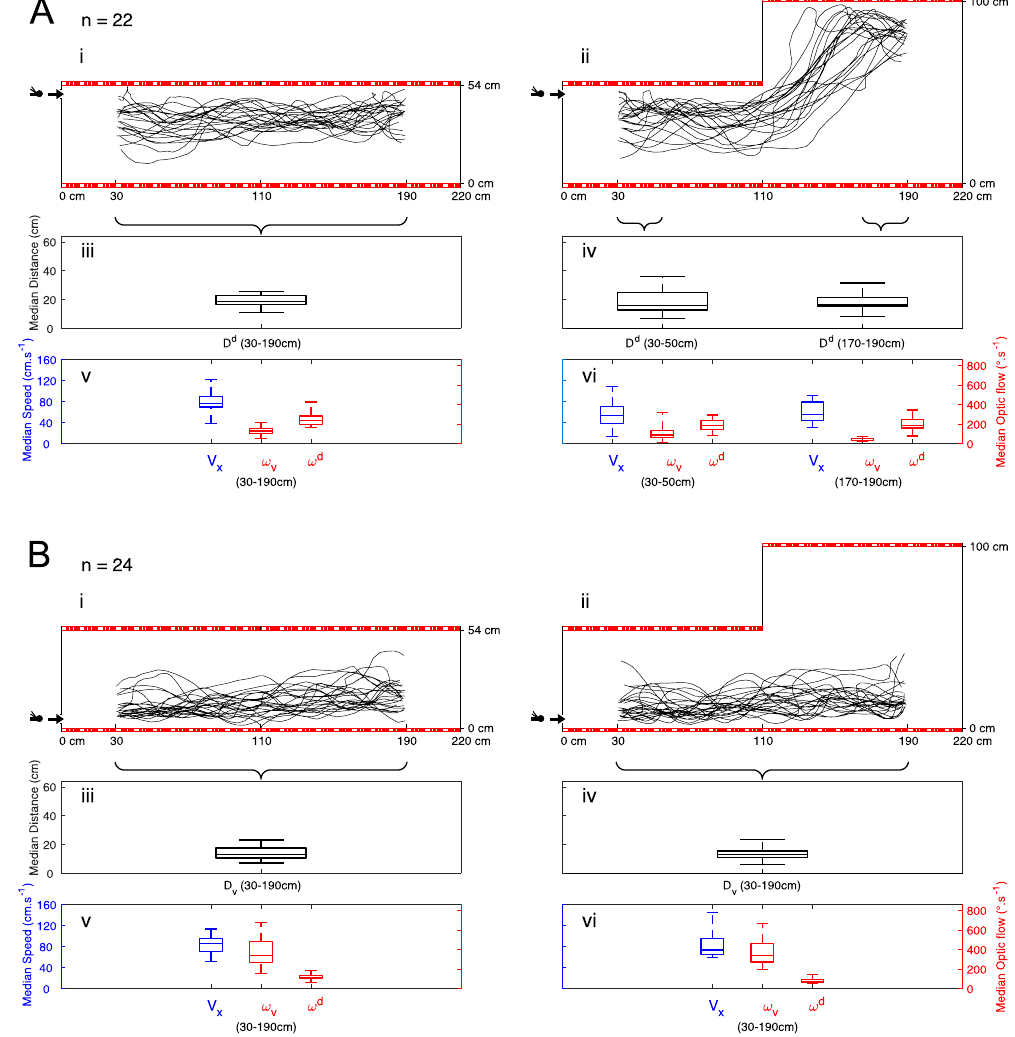
Figure 1. ( A ) Step 0: E Top → R Top ; Steps i&ii: E Top Trajectories of honeybees ( n = 22) trained to enter the tunnel via the upper entrance before being released at the upper entrance under low-roof conditions, as described in i as well as under “dorsal ditch” conditions, as described in ii. In the flight under “dorsal ditch” conditions which the bees had not previously experienced, the insects flew upward and followed the newly encountered high roof at median distances D d (see boxplots in iii and iv) which were not significantly different. Distributions of median speed v x and median dorsal optic flows ω d (see boxplots in v and vi) were also not significantly different each others. ( B ) Step 0: E Bottom → R Bottom ; Steps i&ii: E Bottom . Trajectories of honeybees ( n = 24) trained to enter the tunnel via the lower entrance before being released at the lower entrance under low-roof conditions, as described in i and again via the lower entrance under “dorsal ditch” conditions, as described in ii. In the flight under “dorsal ditch” conditions which the bees had not previously experienced, the insects flew near the floor at median distances D v (see boxplots in iii and iv) which were not significantly different. Distributions of median speed v x and median ventral optic flow ω v (see boxplots in v and vi) were also not significantly different each others. (See statistics in results and discussion